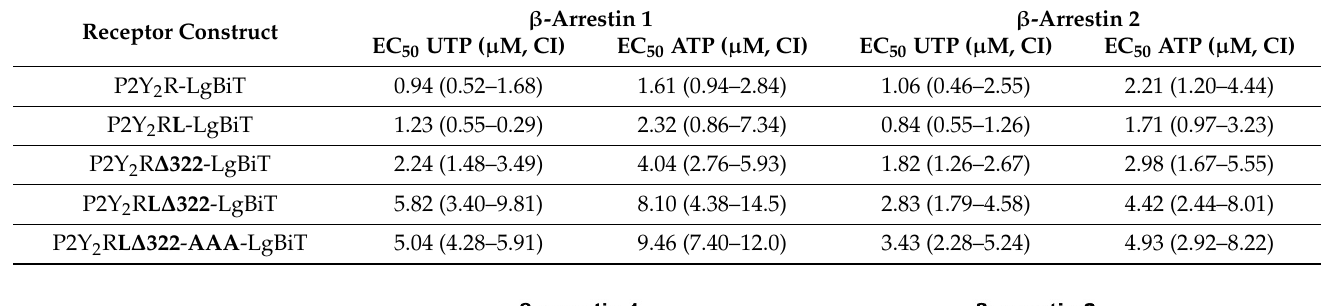
Table 1. EC 50 values, as a measure of the potency of either UTP or ATP to induce the recruitment of β arr1 or β arr2 to the (modified) P2Y 2 R constructs in the NanoBiT ® system. Data are from three in- dependent experiments, each performed in duplicate. CI: 95% confidence interval.